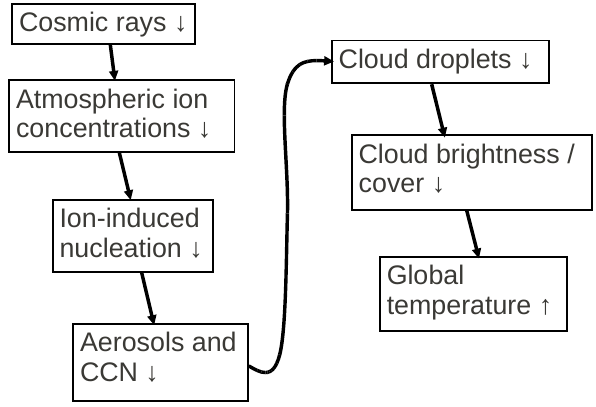
Fig. 1. The ion-aerosol clear-sky mechanism showing how cloud cover could be reduced and temperature could be increased from a decrease in cosmic